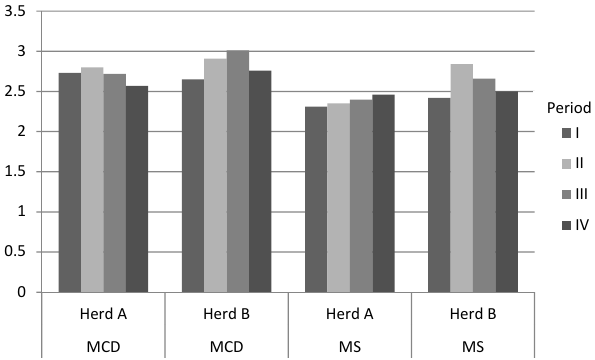
Figure 2. Levels of milkings per cow per day (MCD) and milking speed (MS, kgmin − 1 ) in herds under study.